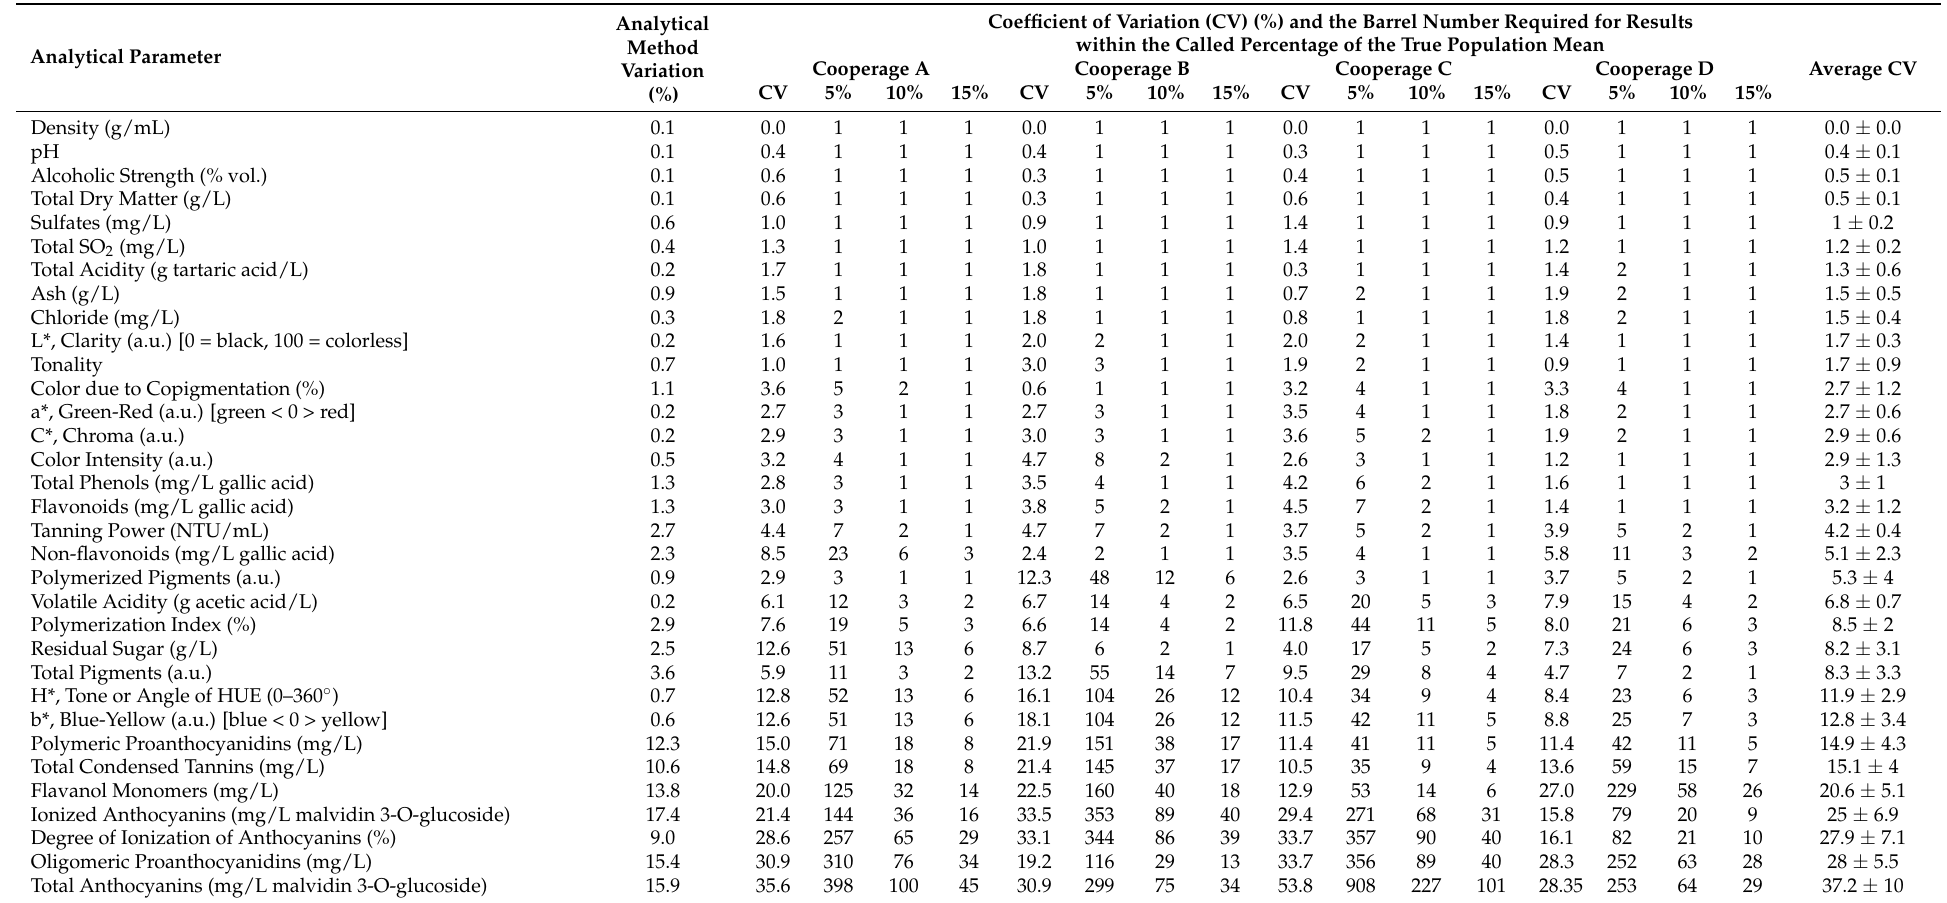
Table 3. Variation of general physical–chemical composition, color, pigments, and phenolic composition of red wines after 12 months of aging in oak barrels according to cooperage, and required barrel number per lot for different levels of